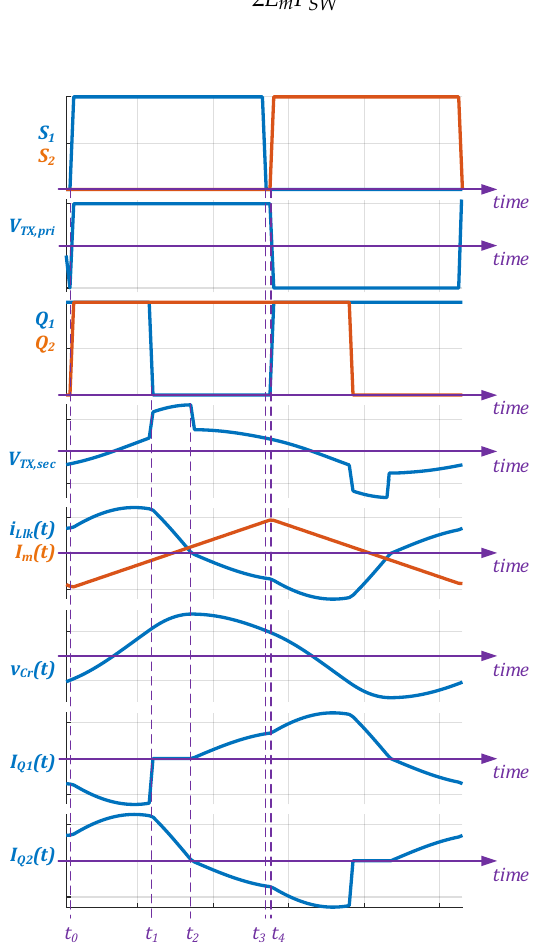
Figure 2. Idealized steady-state waveform of the bridgeless converter for the abnormal operating conditions when ∆𝑉 𝐶𝑟 > 2𝑛𝑉 𝐼𝑁 .